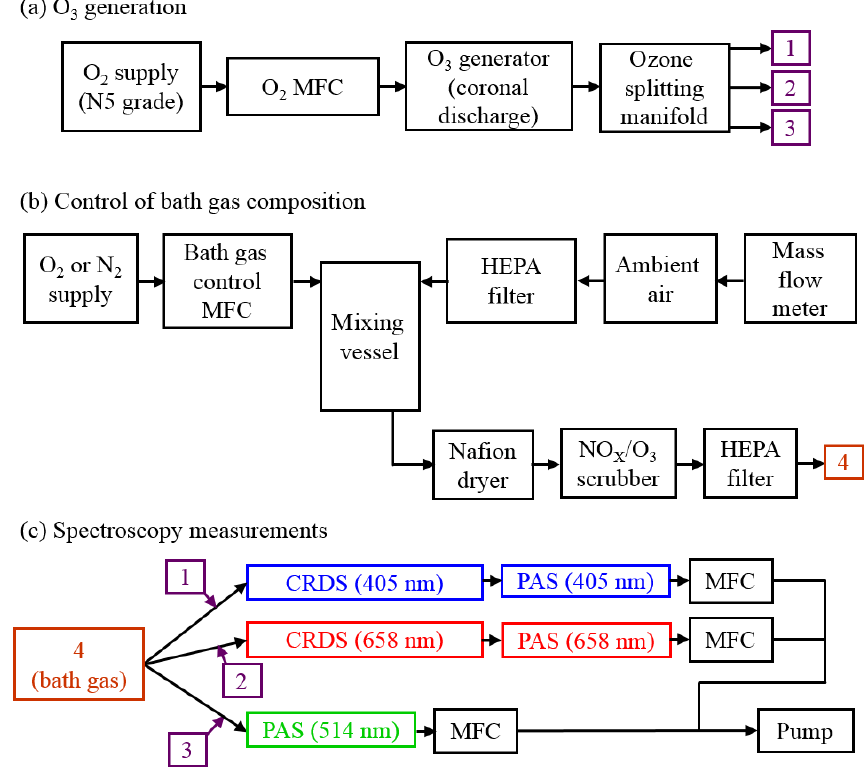
Figure 1. Schematic diagrams of the experimental arrangements for (a) the generation of ozone, (b) the control of the composition of the bath gas, and (c) performance of CRDS and PAS measurements of extinction and absorption, respectively, at different optical wavelengths. MFC denotes a mass flow